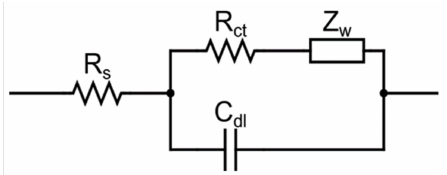
Figure 4. Simulating electrode–solution interface (C dl